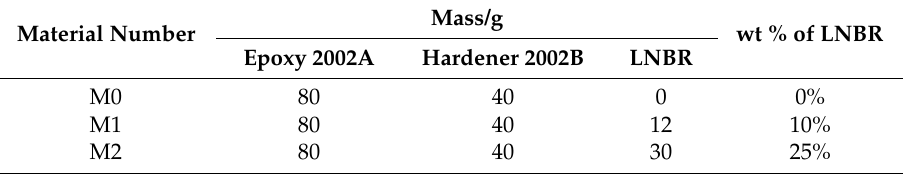
Table 1. Constituents of test